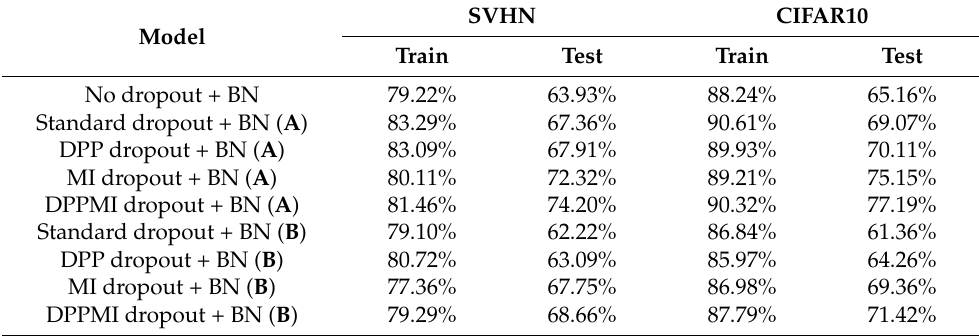
Table 4. Comparisons of train/test accuracies for various benchmarks using batch normalization and dropout algorithms. ( A ) and ( B ) denote dropout layer A fter and B efore BN layer, respectively. SVHN CIFAR10 Model Train Test Train Test No dropout + BN 79.22% 63.93% 88.24% 65.16% Standard dropout + BN ( A ) 83.29% 67.36% 90.61%